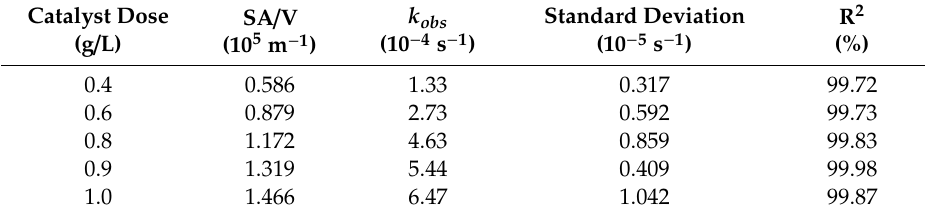
Figure 11. ( A ) ln([Rh B] / [Rh B] 0 ) as a function of reaction time with di ff erent surface area concentrations Figure 11. ( A ) l n([Rh B]/[Rh B] 0 ) as a function of reaction time with different surface area concentrations (5.86 − 14.66 × 10 4 m − 1 ). Reaction conditions: [Rh B] 0 = 20 mg/L, [H 2 O 2 ] 0 = 10 mM, V = 100 mL, T = 25 °C, pH 4.9 (unadjusted). ( B ) k obs as a function of SA/V. The k obs values were obtained from Table 2. The key parameters of the fitted curves in Figure Table 2. The key parameters of the fitted curves in Figure 11A.